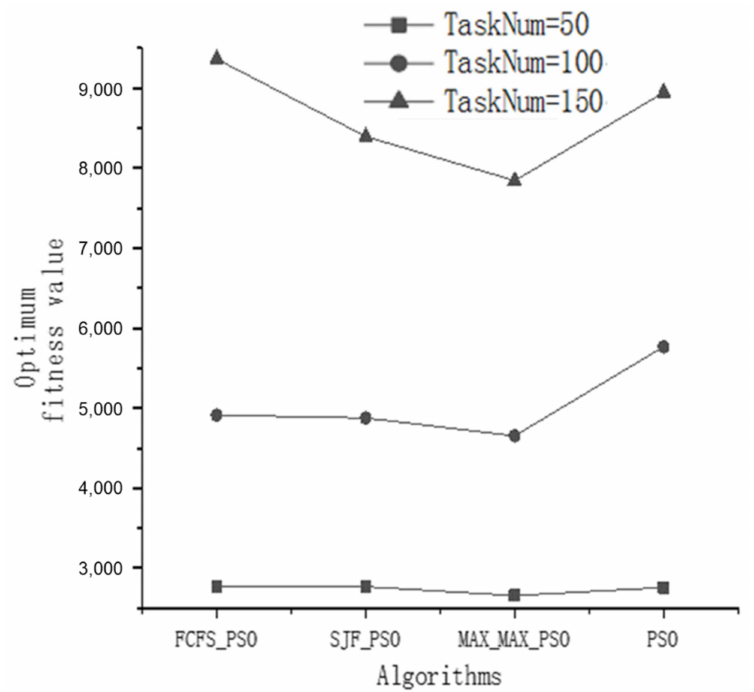
Figure 3. Optimal fitness values of different algorithms.